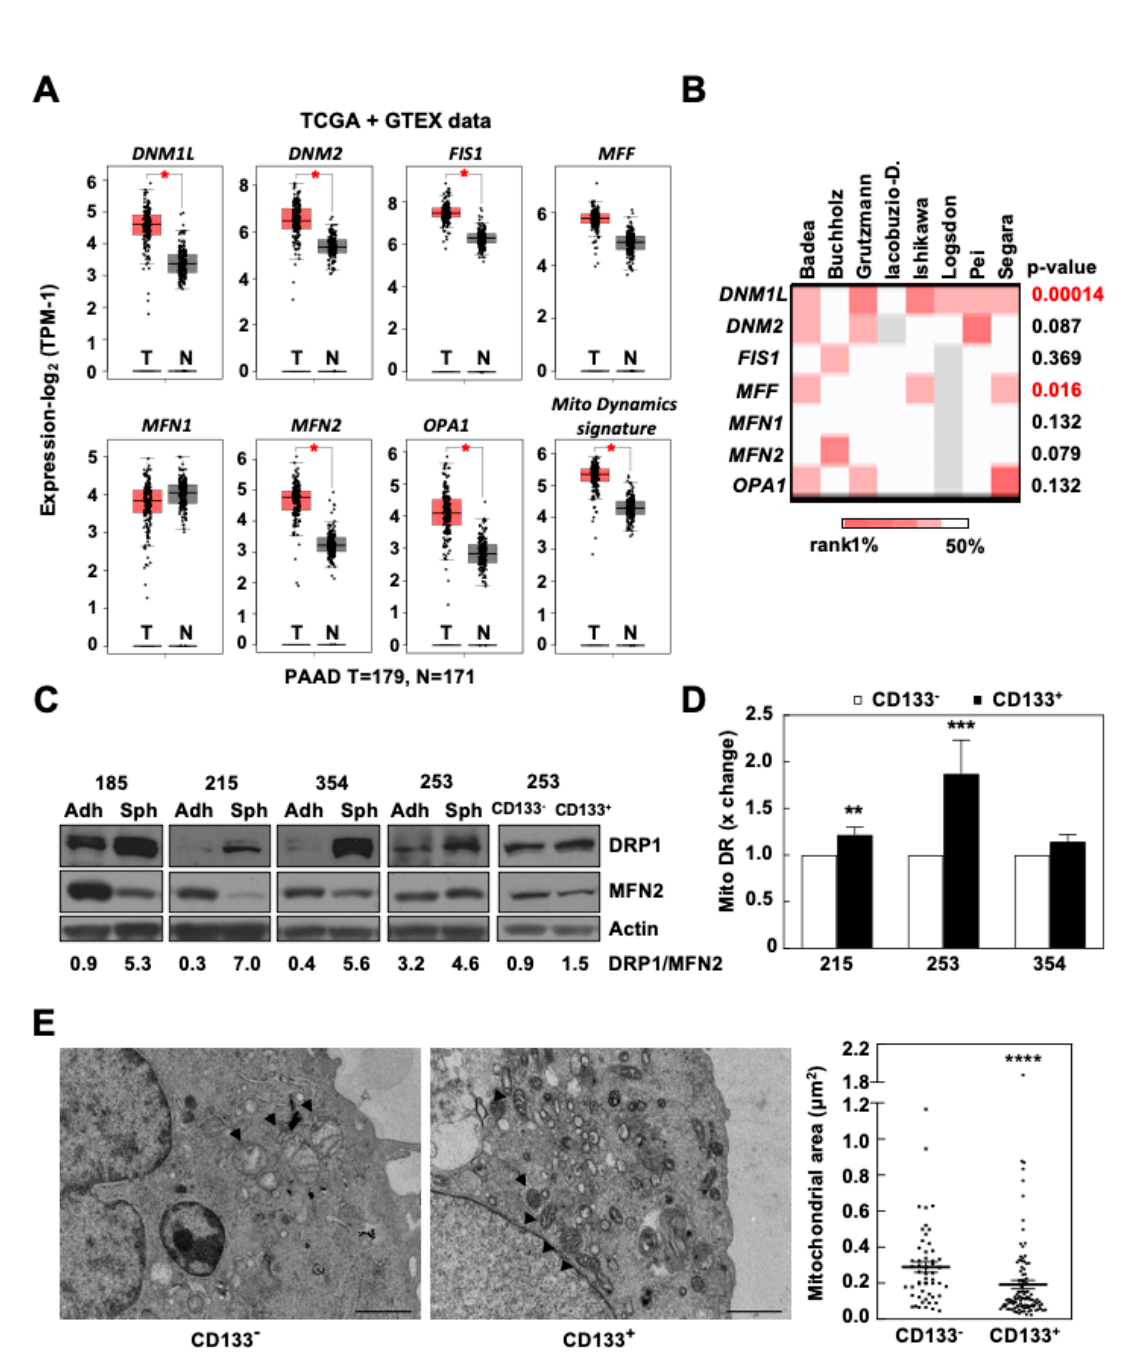
Figure 1. Mitochondrial fission is associated with stemness in human pancreatic ductal adenocarcinoma (PDAC). ( A , B ) Relative expression of genes regulating mitochondrial dynamics for normal human pancreas (N) and PDAC tissues (T), respectively, using TCGA and GTEx (( A ) webtool GEPIA2) or other datasets (( B ) Oncomine TM ). TPM, transcripts per million. * p < 0.01. In ( B ), the color-coded rank illustrates the rank of the p -value for each indicated gene relative to the global list of up-regulated genes for the respective dataset (top 1%, top 10%). ( C ) Western blot for DRP1 and MFN2 in cancer stem cell (CSC)-enriched conditions (spheres (Sph) or CD133 + sorted cells) compared to their differentiated counterparts (cells grown in adherence (Adh) or CD133 − sorted cells) in four different PDAC models. The numbers below show the normalized DRP1/MFN2 expression ratio. β -actin was used as a loading control. ( D ) Mitochondrial mass as determined by flow cytometry using MitoTracker TM Deep Red FM (Mito DR) in CD133 − and CD133 + cells ( n = 6–8). Control set as 1 for fold change. ( E ) Transmission Electron Microscopy pictures (12,000×) and quantification of the mitochondrial area for CD133 − and CD133 + 185 cells, respectively ( n = 7–17 cells or 54 vs. 107 mitochondria). ** p < 0.01, *** p < 0.001, **** p < 0.0001; Mann–Whitney test. Data represent averages ±